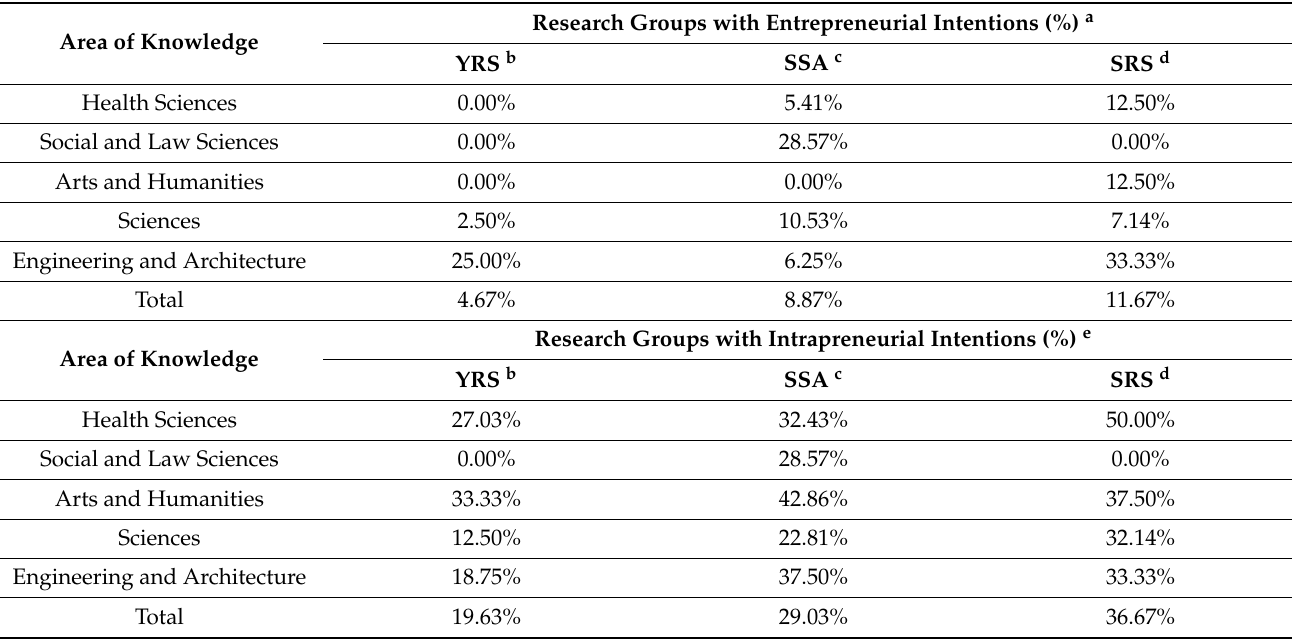
Table 4. Entrepreneurial and intrapreneurial intentions by area of knowledge and research